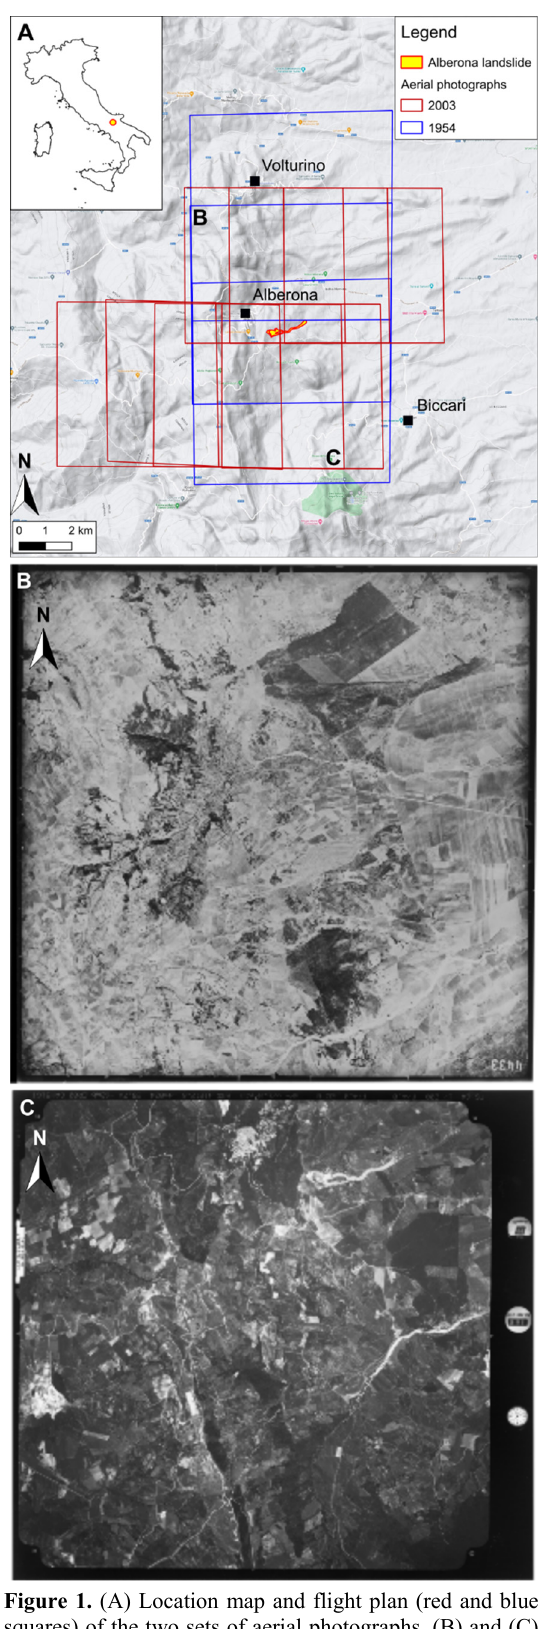
Figure 1. (A) Location map and flight plan (red and blue squares) of the two sets of aerial photographs. (B) and (C) examples of aerial photographs of 1954 and 2003, respectively, at 100 dpi. Aerial photos by ISTITUTO GEOGRAFICO MILITARE – Authorization